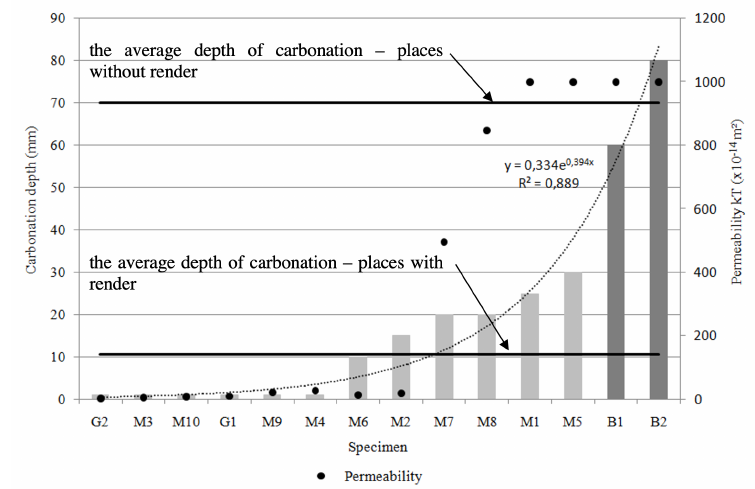
Figure 1. The results of in-situ measurements of the depth of carbonation and permeability at the Bridge in Sládkovi č ovo..